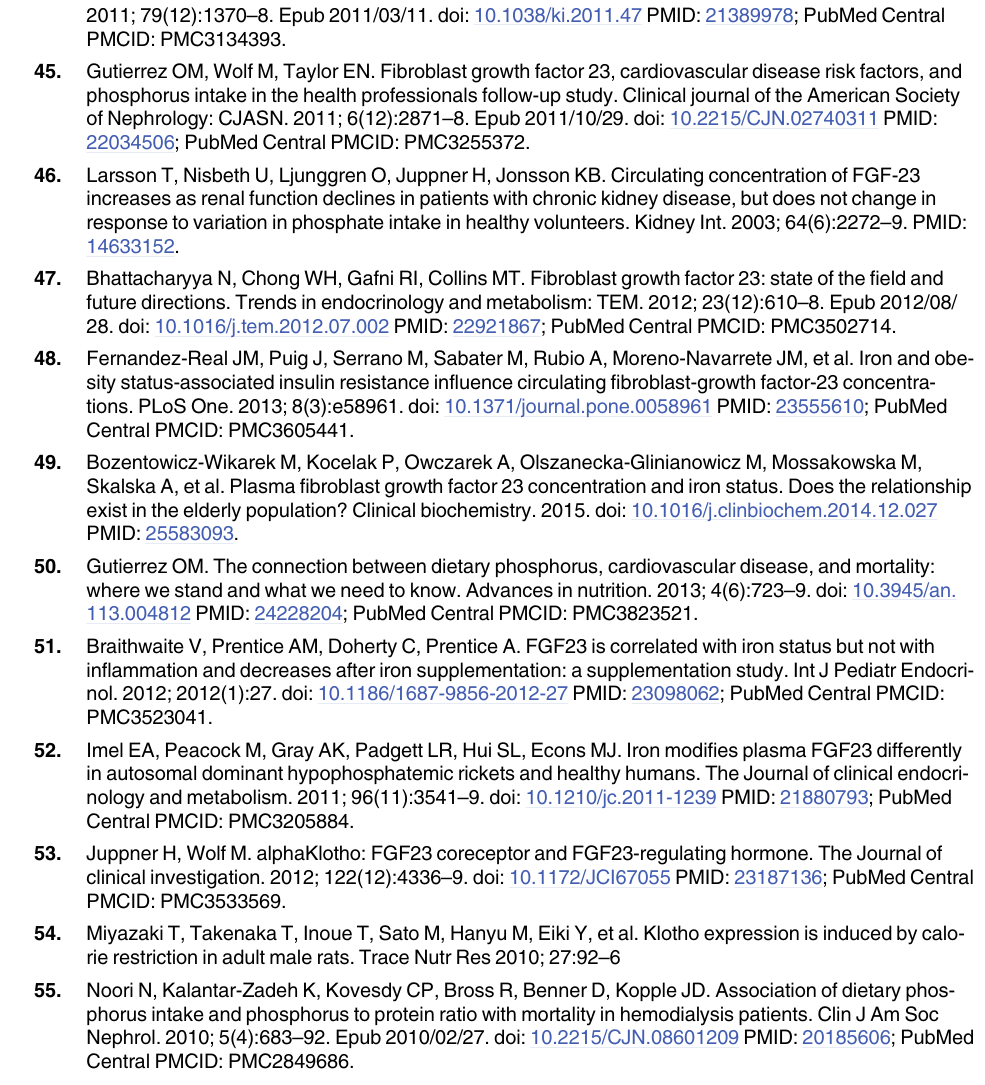
PLOS ONE | DOI:10.1371/journal.pone.0133580 July 20,